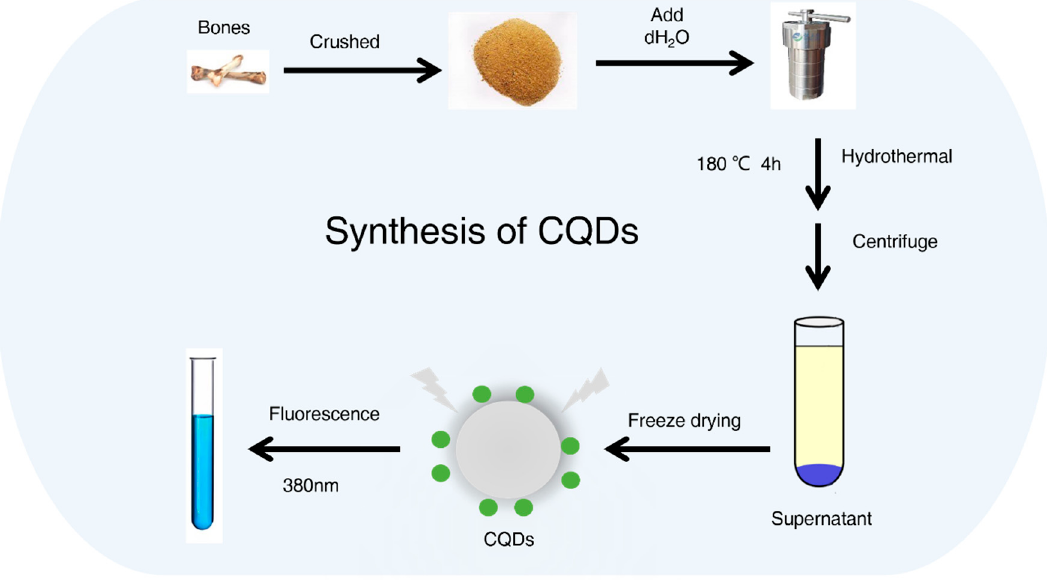
Figure 1. Procedure for preparing carbon quantum dots (CQDs) from waste chicken bones.